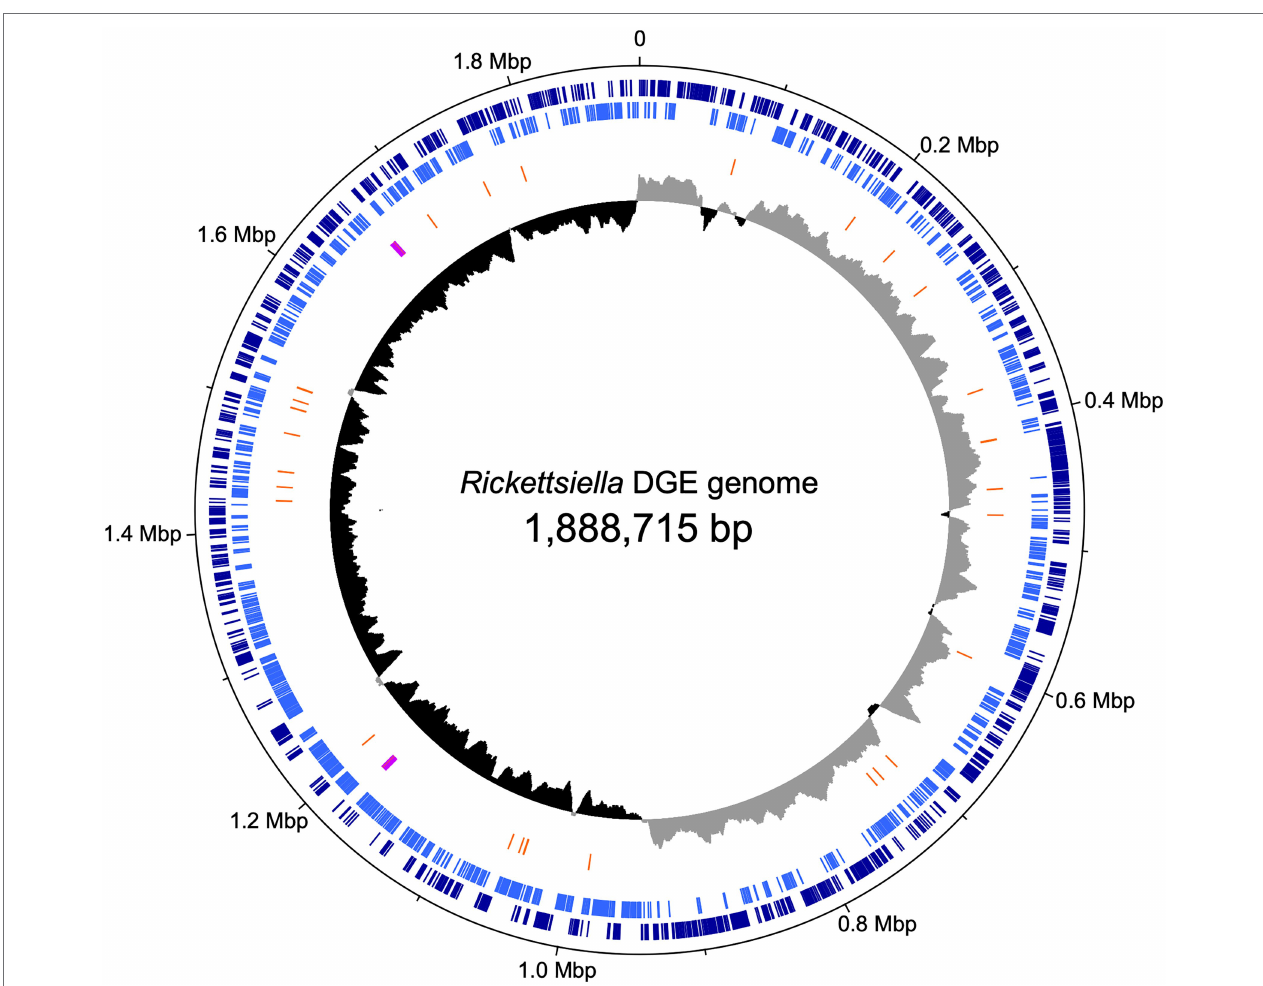
FIGURE 3 | Map of the circular chromosome of Rickettsiella DGE. The innermost circle shows GC skew (window size: 10,000 bp) with gray and black indicating high (>0) and low (<0) (G − C)/(G+C) values. The second circle shows the positions of tRNA genes (orange) and rRNA genes (purple). The outer circles indicate the positions of protein coding genes on the plus strand (dark blue) and minus strand (light